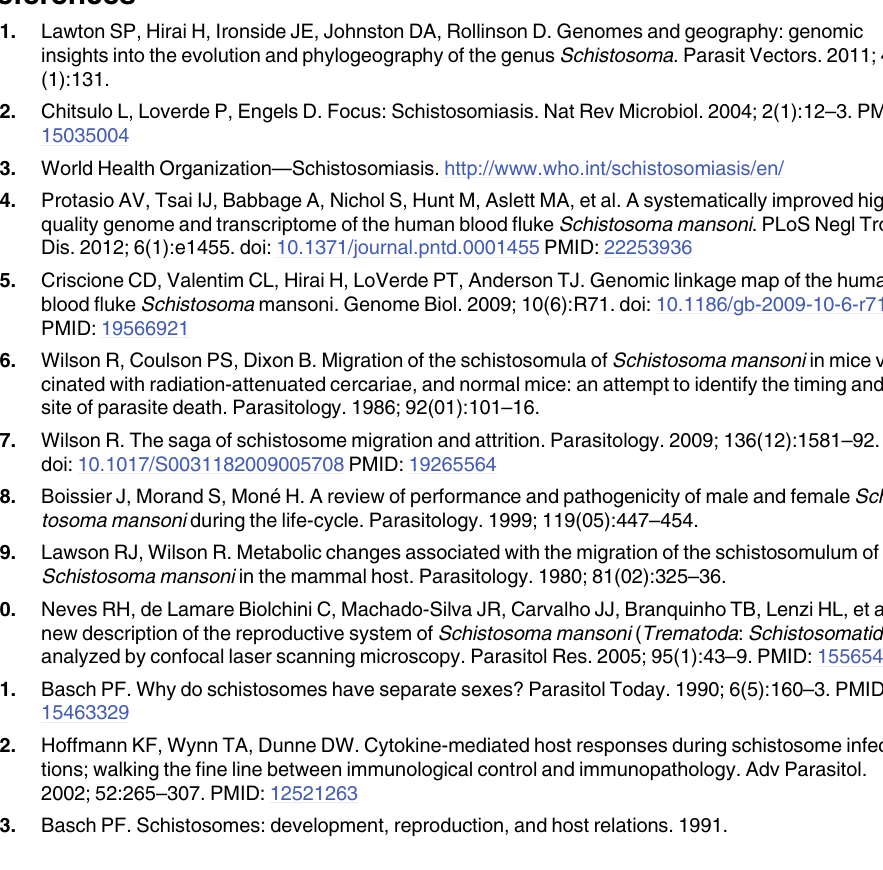
S6 Table. Gene annotation and expression levels of clustered genes (Correspondingto Fig 3). S7 Table. Micro-exon gene